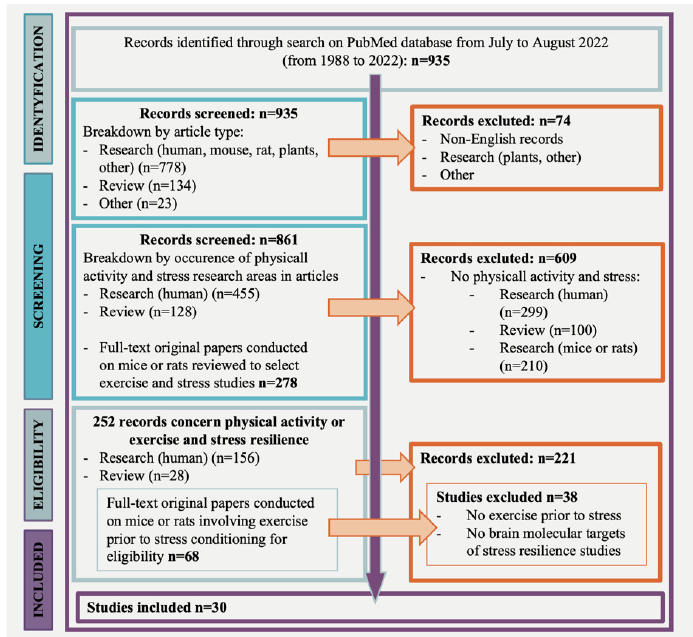
Figure 1. Flow chart of research strategy.